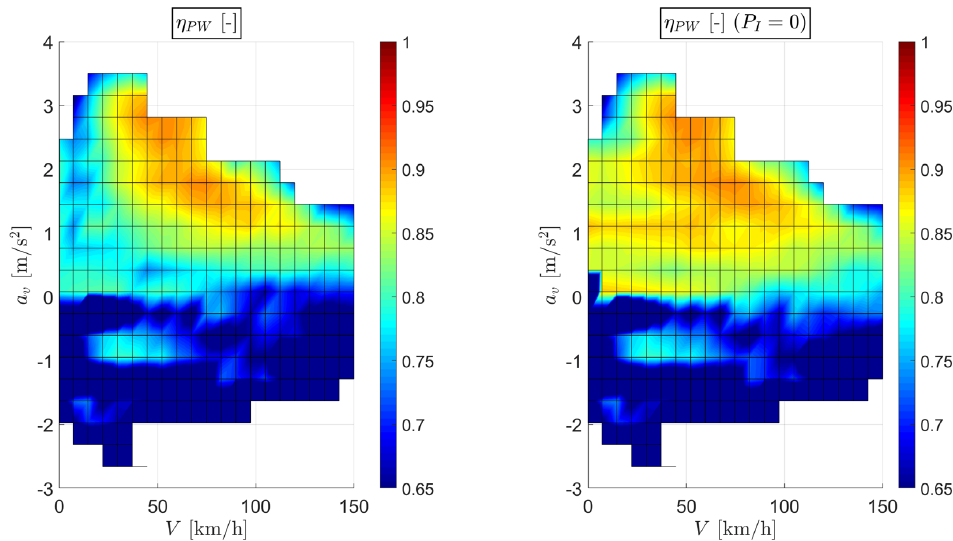
Figure 12. Power-weighted efficiency with ( left ) and without ( right ) the activation of the penalty factor P I for the Input Split mode and road slope α = 0.